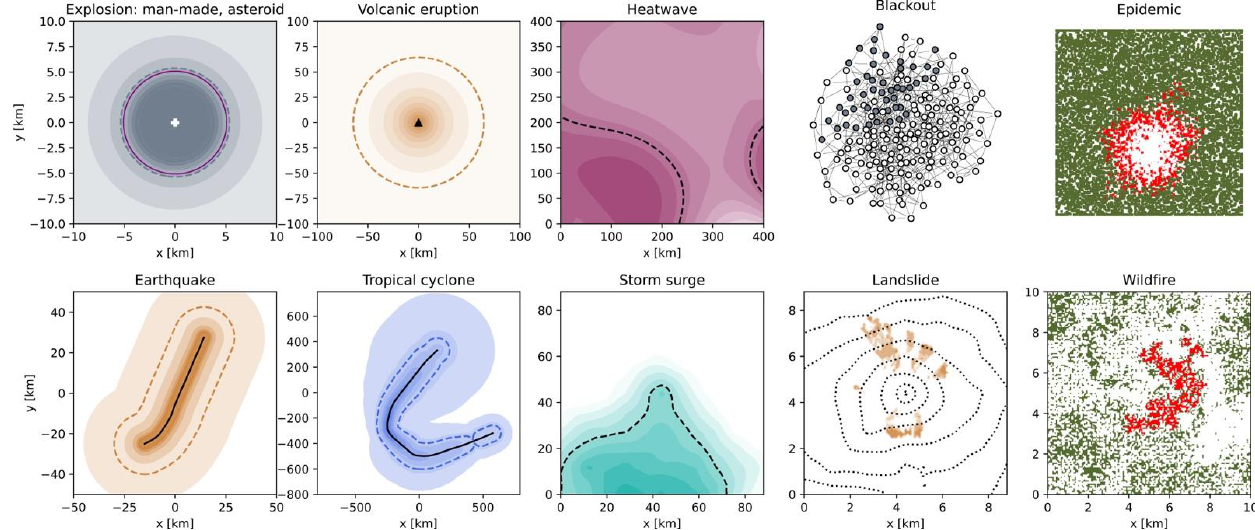
Figure 6. Examples of hazard intensity footprints based on analytical expressions (first two columns, Section 2.4.1), threshold models (central column, Section 2.4.2), and numerical models (last two columns, Section 2.4.3). DIFFUSION (POINT SOURCES) — Explosion (incl. asteroid impact): overpressure field 𝑝(𝑥,𝑦) for an ad-hoc 𝑚 𝑇𝑁𝑇 = 1 Mton event (Equation (30)) with a 4-psi dashed contour in grey and matching 4-psi contour from Equation (28) in purple. Volcanic eruption: Ash depth map ℎ(𝑥,𝑦) for a 𝑉 = 2.9 km 3 (e.g., 1980, Mt St. Helens) and ℎ 0 = 1 m event (Equation (33)) with a 5-cm dashed contour in orange. DIFFUSION (LINE SOURCES) — Earthquake: Peak ground acceleration footprint 𝐼(𝑥,𝑦) of an 𝑀 = 6.6 event on the ESHM13 fault segment ITCS073 with depth 𝑧 = 1 km (Equation 29) and a dashed 0.1-g contour in dark orange. DIFFUSION (TRACK SOURCES) — Tropical cyclone: Windspeed map 𝑣(𝑥,𝑦) for the IBTrACS 2005 Hurricane Katrina track (Equation (32) with 𝑝 𝑛 = 1005 mb and log𝑅 = 4.0441 − 1.2090 × 10 −2 (𝑝 𝑛 − 𝑝 𝑐 ) + 7.2694 × 10 −3 𝜙 [161]) with a dashed 35-m/s wind speed contour in dark blue. THRESHOLD (AREA SOURCE) — Heatwave: Temperature map of Southwestern France at 3 pm on 17 July 2022 [44] with a dashed 35°-contour in dark magenta as (ad-hoc) proxy to the heatwave. THRESHOLD (LINE SOURCE) — Storm surge: Inundation map on a random topography (with fractal dimension 𝐷 𝑓 = 2.3 [162]) with dashed 0-m altitude level as a coastline marker. DYNAMIC PROPAGATION (DIFFUSE SOURCES) — Blackout: Ring network with each node (power node or transmission line) connected to four others and with grey nodes as failed (i.e., blackout) following the rules of Equations (39) and (40). Epidemic: Infected and susceptible individuals colored in red and green, respectively, following the rules of Equation (42). Landslide: Event footprint formed of several patches, following the rules of Equations (43) and (44), on a random fractal topography (dotted contours with fractal dimension 𝐷 𝑓 = 2.3 [162]). Wildfire: Burned areas and vegetation represented in red and green, respectively, following the rules of the Forest Fire model.